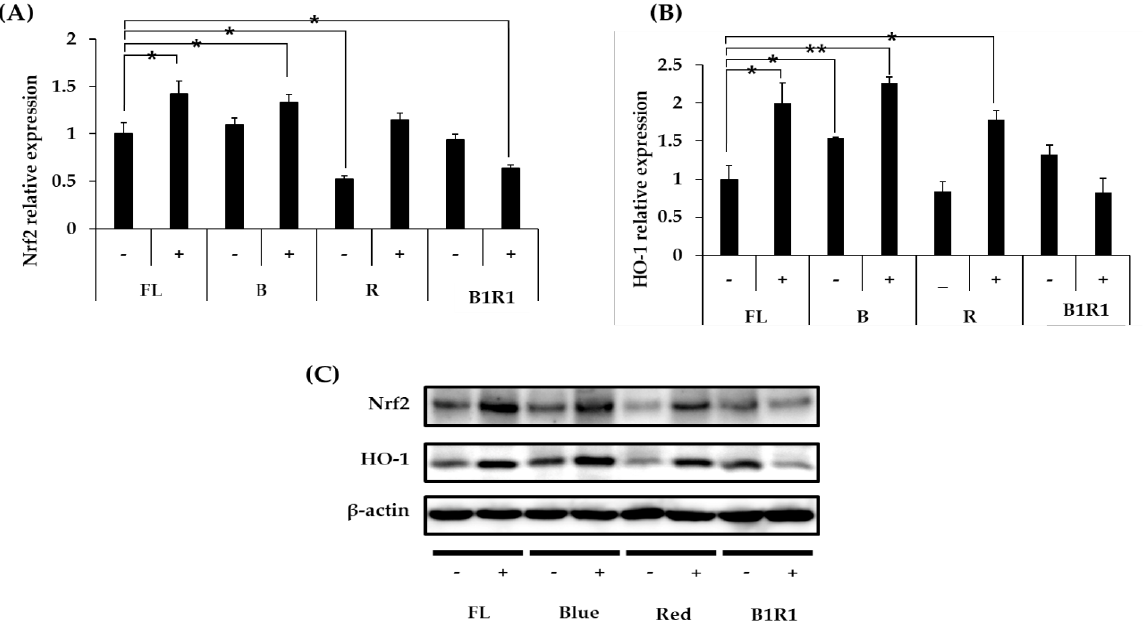
Figure 5. Effect of B. carinata microgreen extracts on the nuclear factor-erythroid 2-related factor (Nrf2) ( A ) and heme- oxygenase (HO-1) ( B ) protein expression in cells. Cells were treated with 100 µg/mL extracts for 48 h and the total expressed HO-1 protein and the Nrf2 were analyzed by Western blot ( C ) with β -Actin as the internal control. All data were presented as means ± standard error ( n = 3. Student t ‐ test was conducted to see the differences between relative expression of extracts from the control (fluorescence (FL) in absence of salt ( − )) and extracts from treatment groups exposed to blue, red, B1R1 (blue plus red) in absence and presence (+) of salt, * = p < 0.05 and ** = p < 0.01 vs. the control.